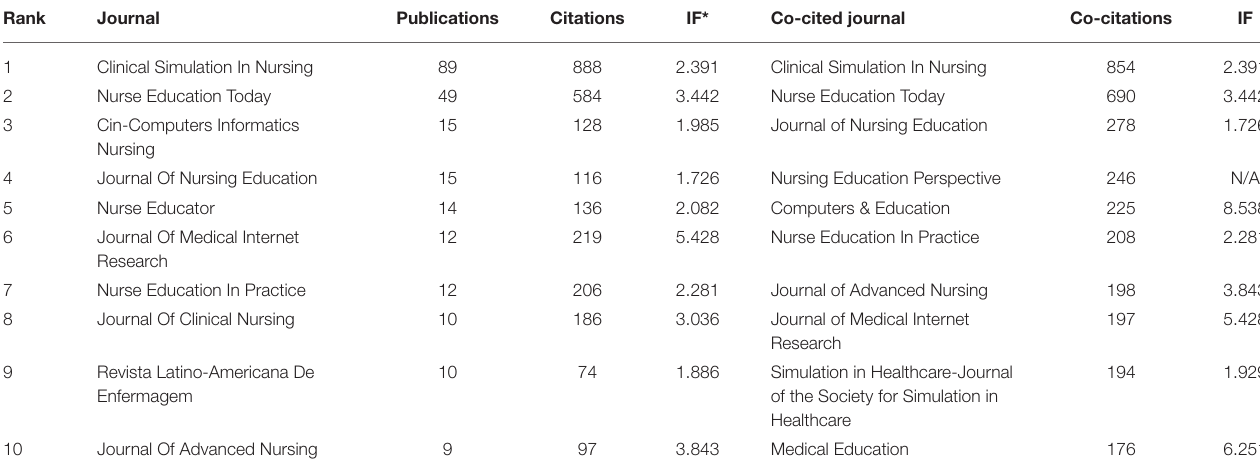
TABLE 2 | Top 10 prolific journals and co-cited journals on virtual simulation research in